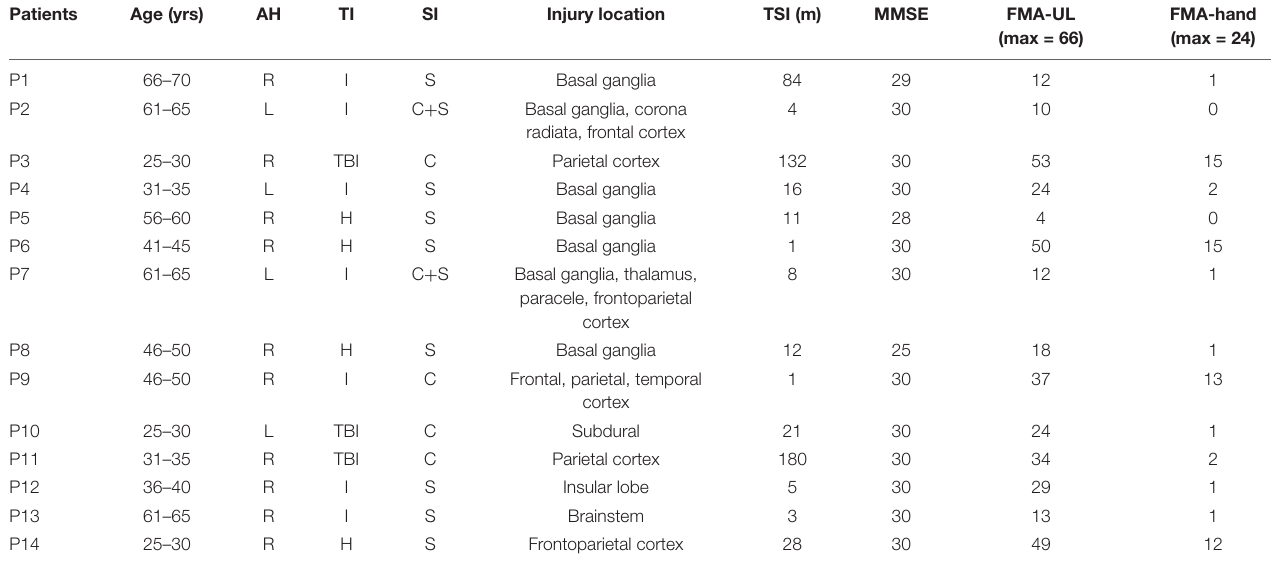
TABLE 1 | Demographics and clinical characteristics of the patients.